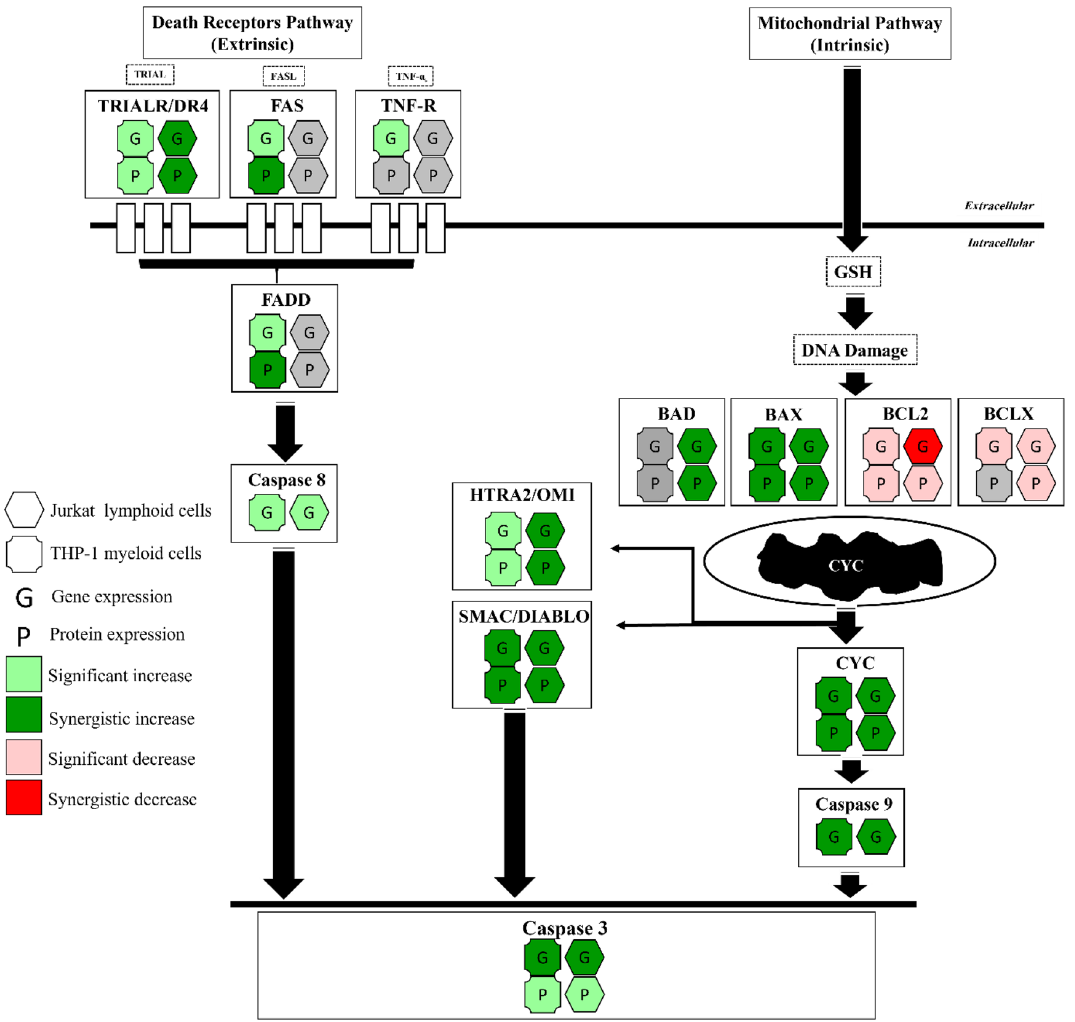
Figure 9. A summary of the effects of apigenin and cyclophosphamide combination treatments on apoptosis- related gene and protein expression in acute leukaemia cells (Jurkat and